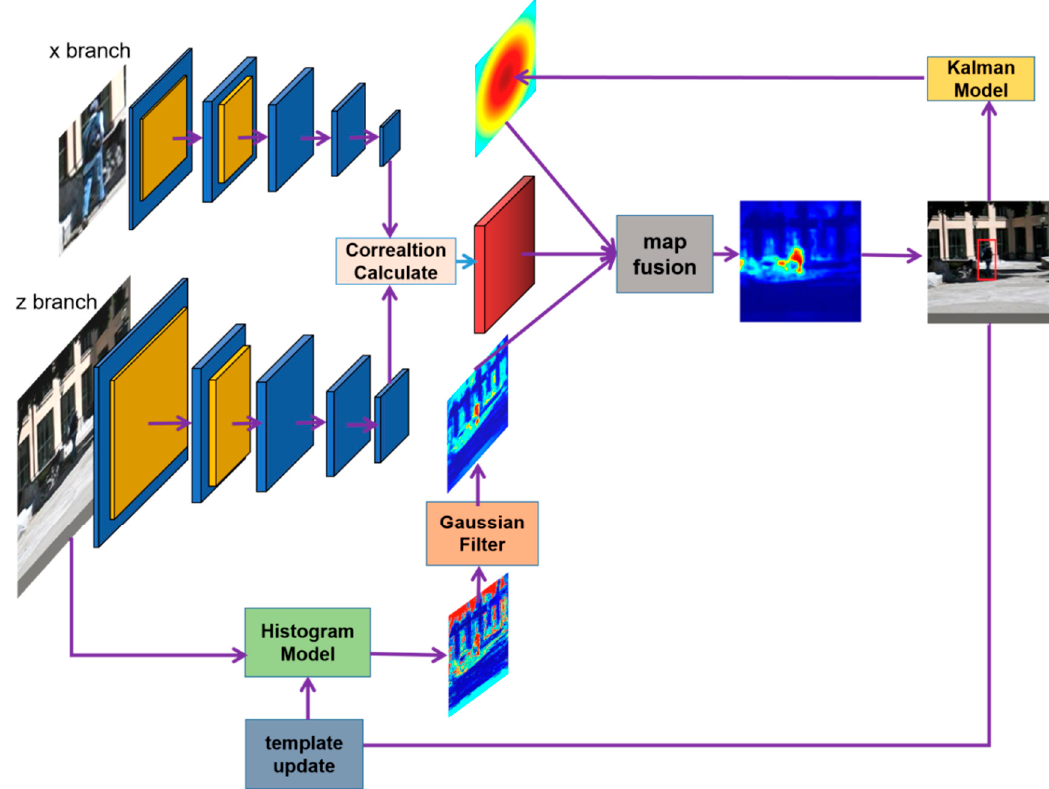
Figure 1. Basic workflow of our Histogram–Kalman SiamFC (HKSiamFC) tracker. The two-branch convolutional neural network (CNN) has the same architecture as the original fully-convolutional Siamese (SiamFC) tracker. We adopted the histogram model from Staple in HKSiamFC and used it to generate a histogram-score map, and we then optimized it with a Gaussian filter; this map is used to provide prior information about target appearance. We also designed a Kalman model to generate a Gaussian likelihood map based on a Kalman filter to provide prior information about target motion. Finally, we combined all three maps to capture the target.